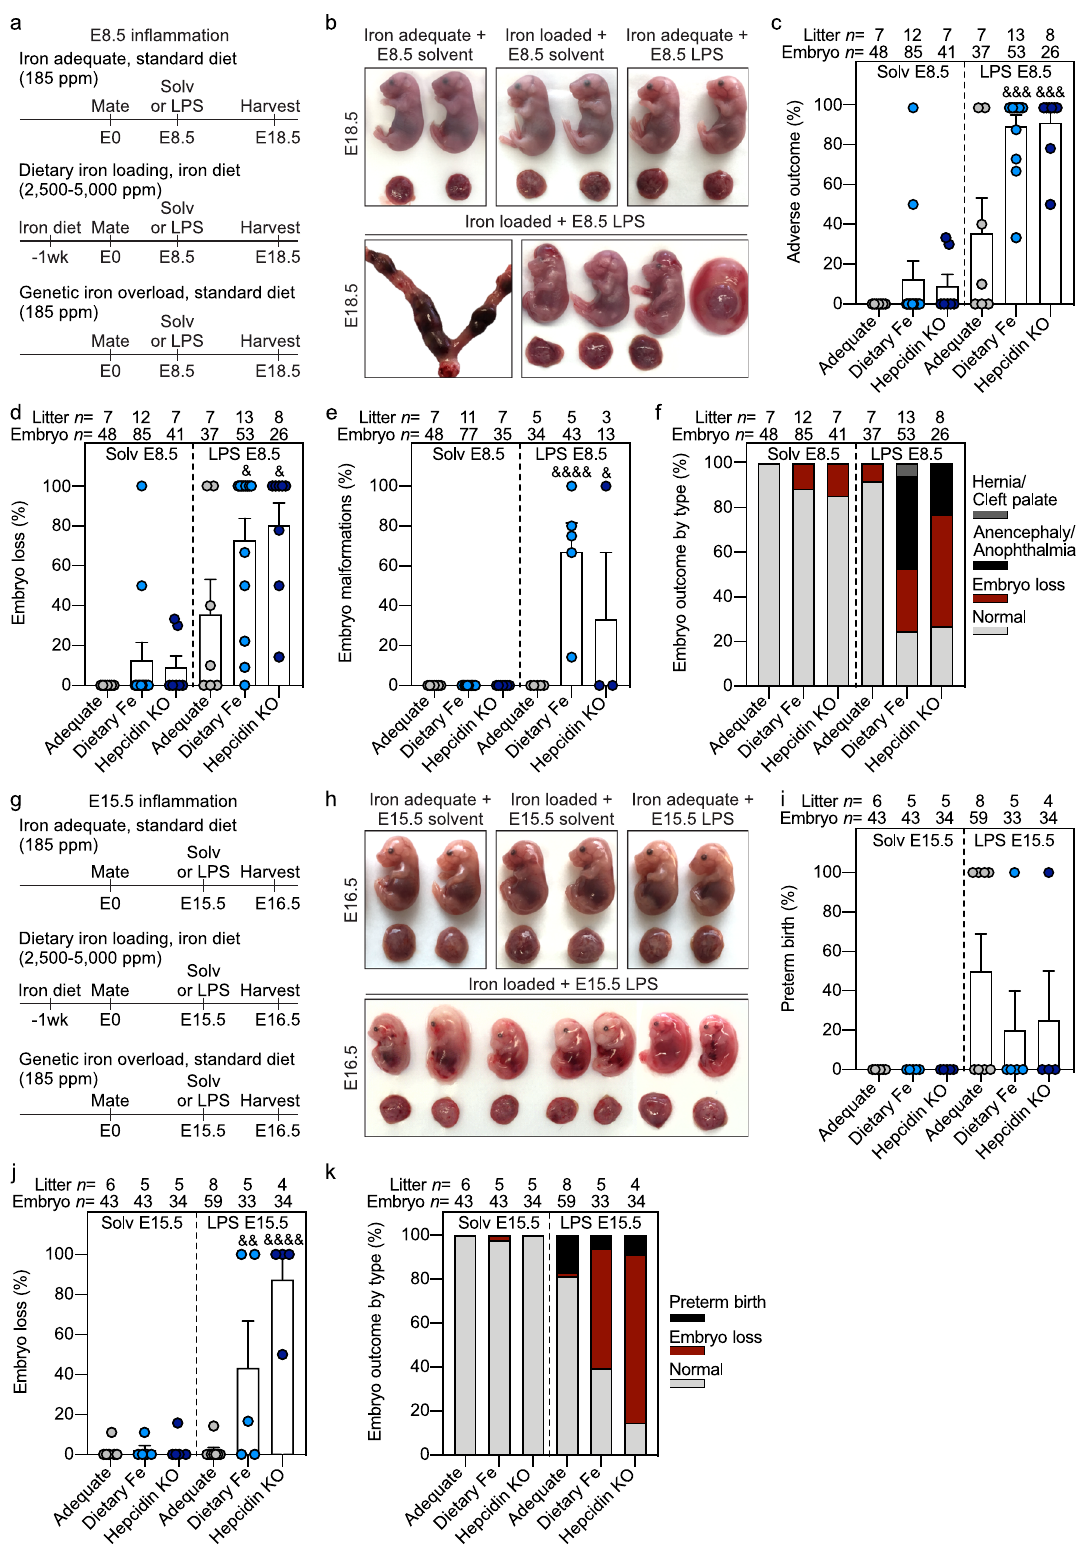
after 24 h (Fig. 1g). Solvent injections did not cause preterm birth or embryo resorption in any groups, con fi rming that maternal iron loading by itself does not cause severe damage to embryos. In dams with normal iron status, E15.5 LPS injection caused preterm birth in 50% of dams, but embryos appeared normal with only 2% lethality (Fig. 1h – k). In iron-loaded dams, however,